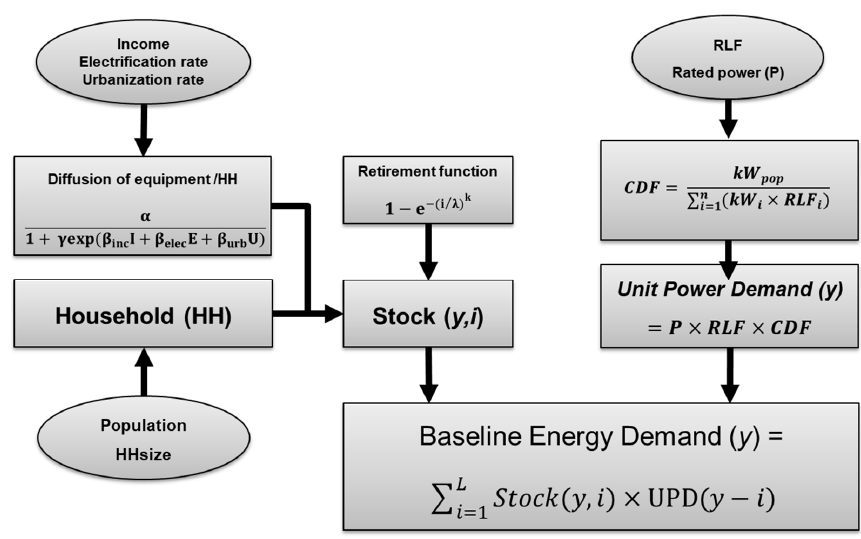
Figure 5. Energy demand model structure.